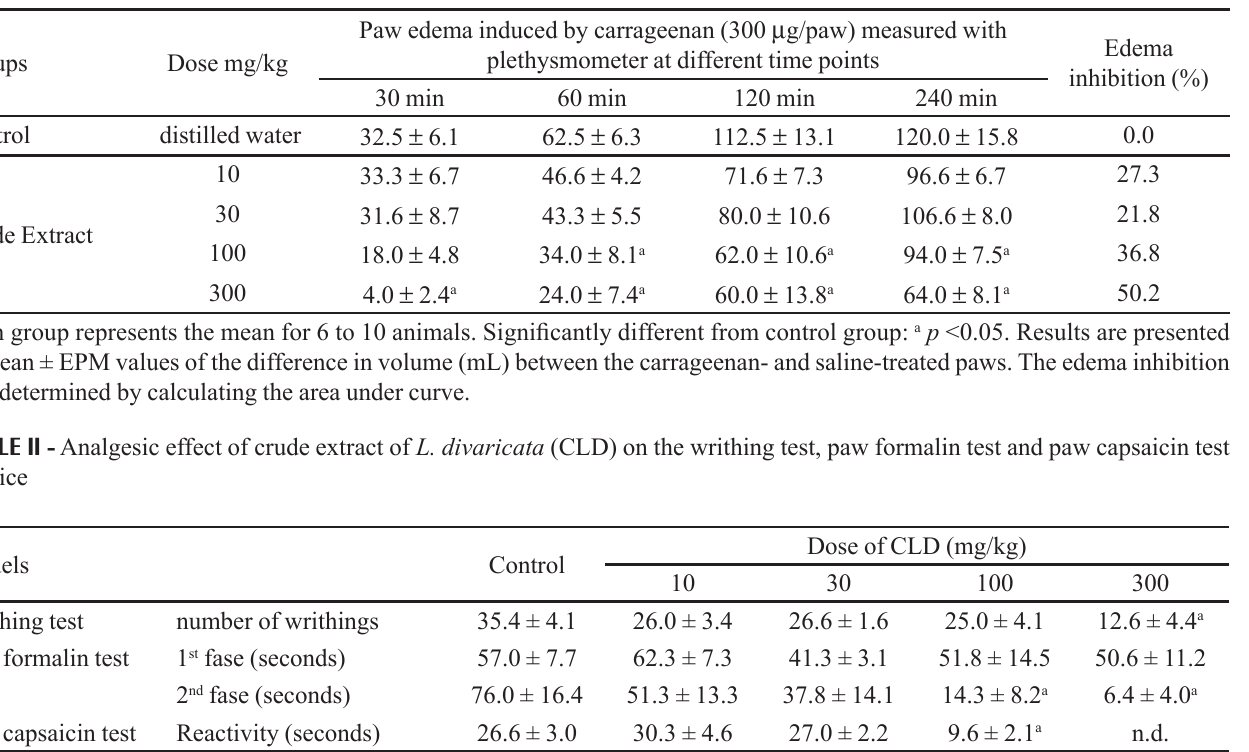
TABLE I - Anti-inflammatory effect of crude extract of L. divaricata (CLD) on the paw edema induced by carrageenan test in mice Paw edema induced by carrageenan (300 m g/paw) measured with plethysmometer at different time points Groups Dose mg/kg Control